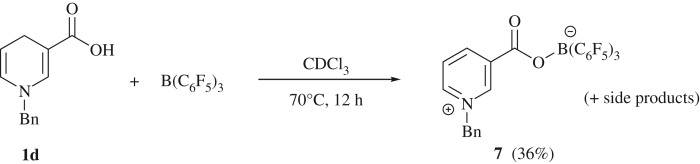
Reaction between 1-benzyl-1,4-dihydronicotinic acid 1d and B(C6F5)3.